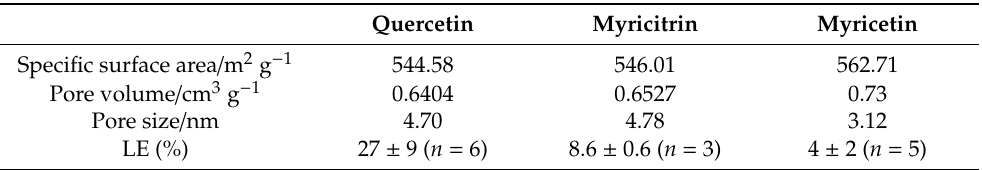
Table 3. Specific surface area, pore volume, pore size and loading e ffi ciency (LE) for flavonoid loaded MSNs determined by BET analysis and UV / VIS